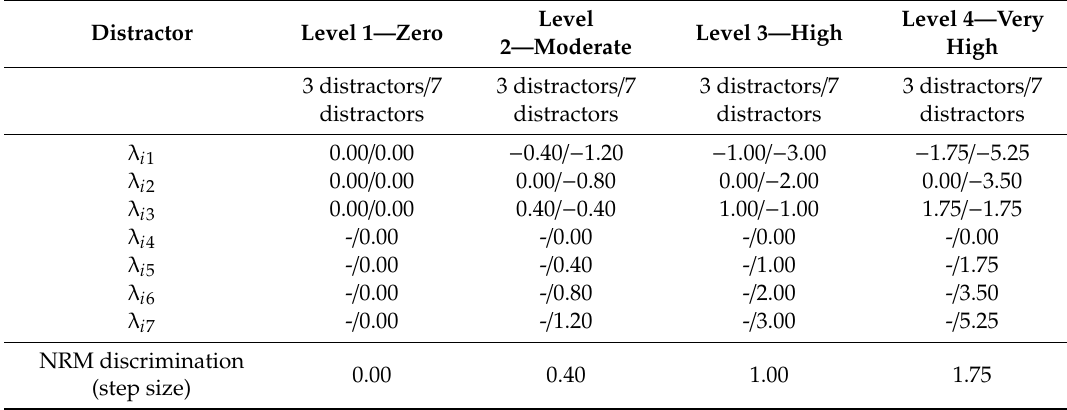
Table 2. NRM discrimination parameters used in the simulation